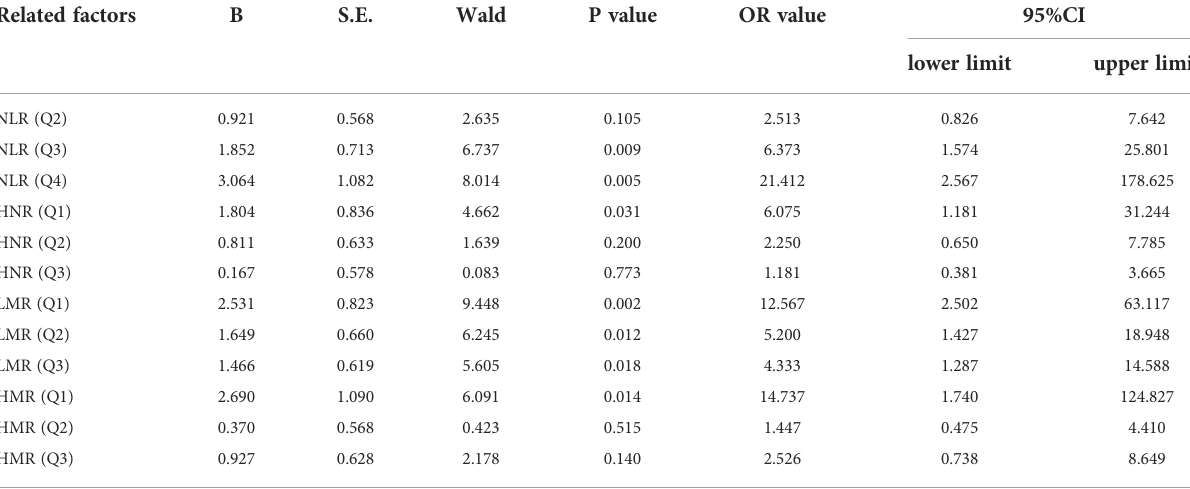
TABLE 7 Univariate Logistic regression analysis of N L R, LMR, HNR, and HMR (all four categories) in the prediction of NSCLC metastasis. Related factors